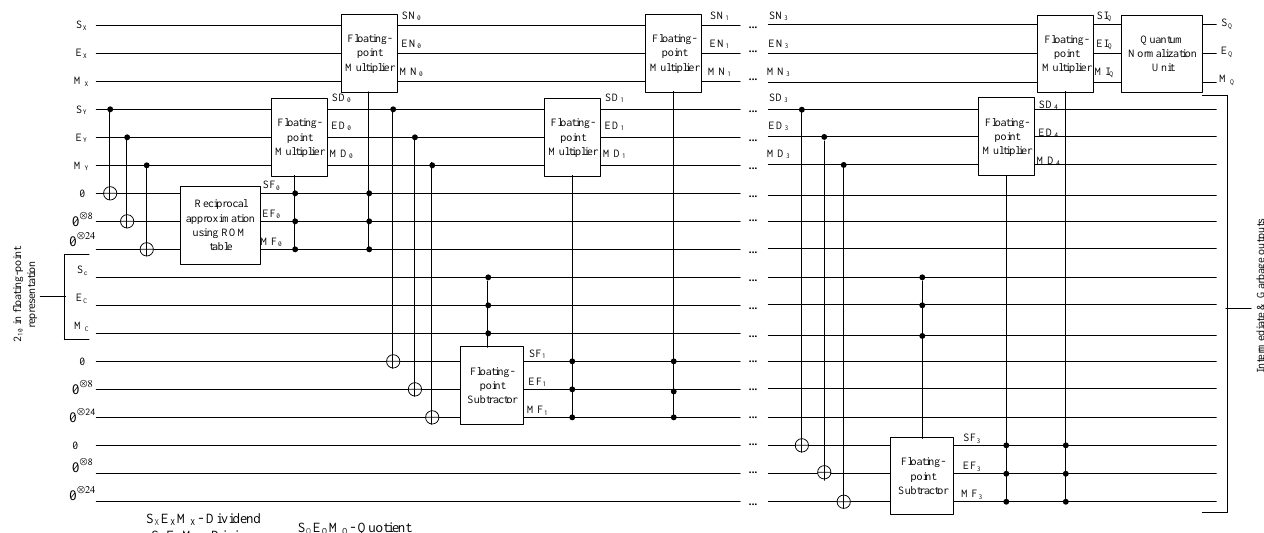
Figure 12. High-level overview proposed division circuit for a single-precision floating-point (SPFP) number using Goldschmidt division